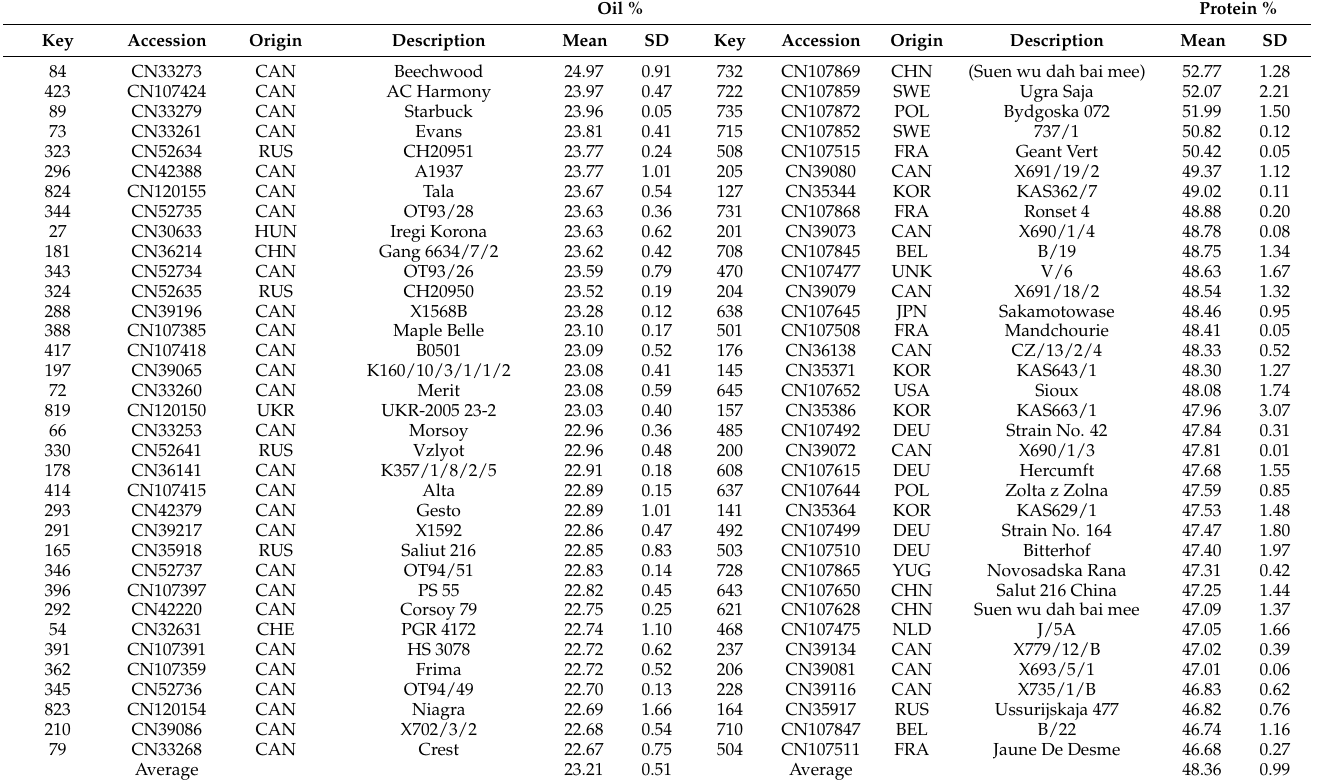
Table 2. The list of PGRC soybean accessions for oil and protein core subsets, along with their accession information and trait values (mean and standard deviation